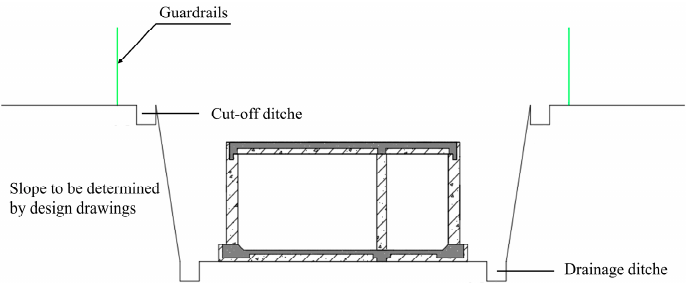
Figure 1. Construction of underground utility tunnel using cut and cover method.